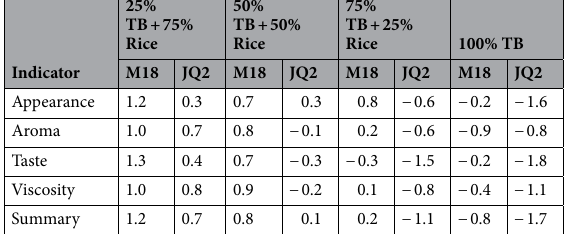
Table 3. Sense organ test of palatability characteristics on Tartary buckwheat. TB Tartary buckwheat. Rice was set as the control.